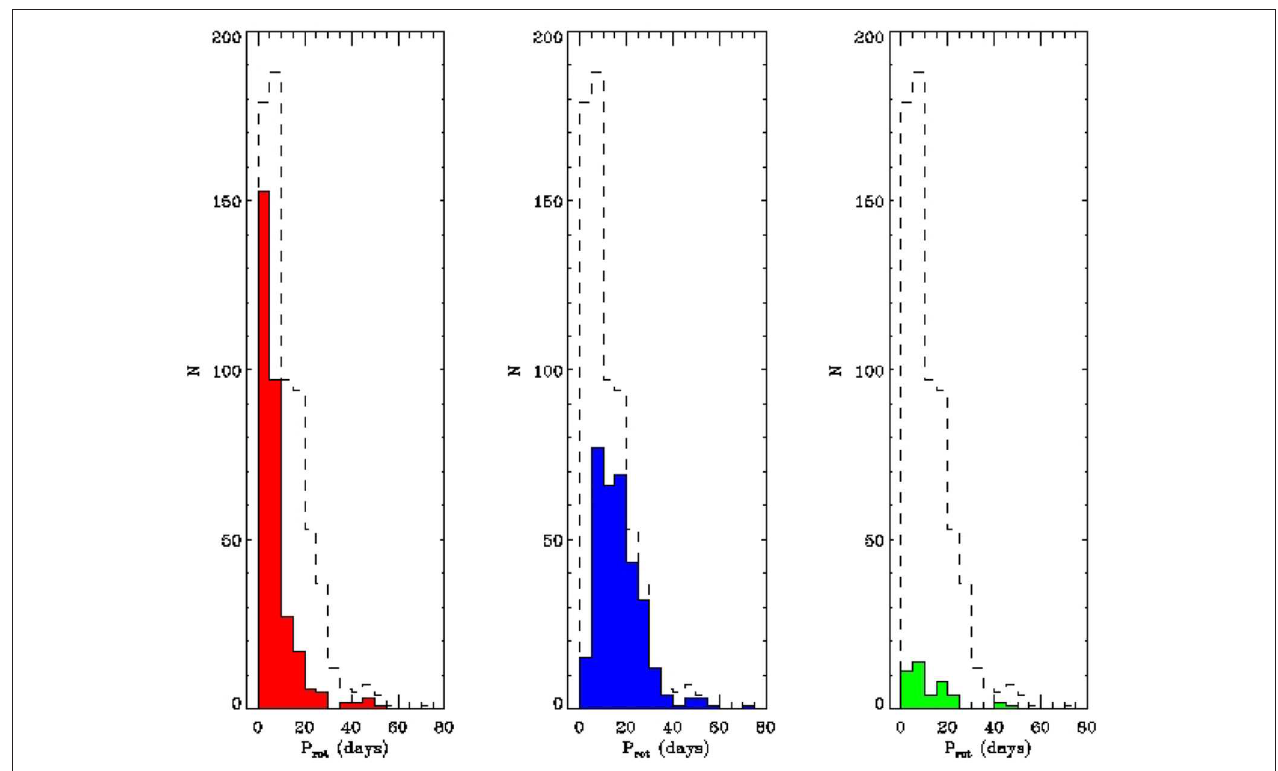
FIGURE 5 | Distribution of the rotation periods for the full sample and the three categories of stars defined in section 4: hot stars (left panel) , cool dwarfs (middle panel) , and subgiants (right panel) . The black dash line in each panel represents the distribution for the full sample of stars with reliable rotation